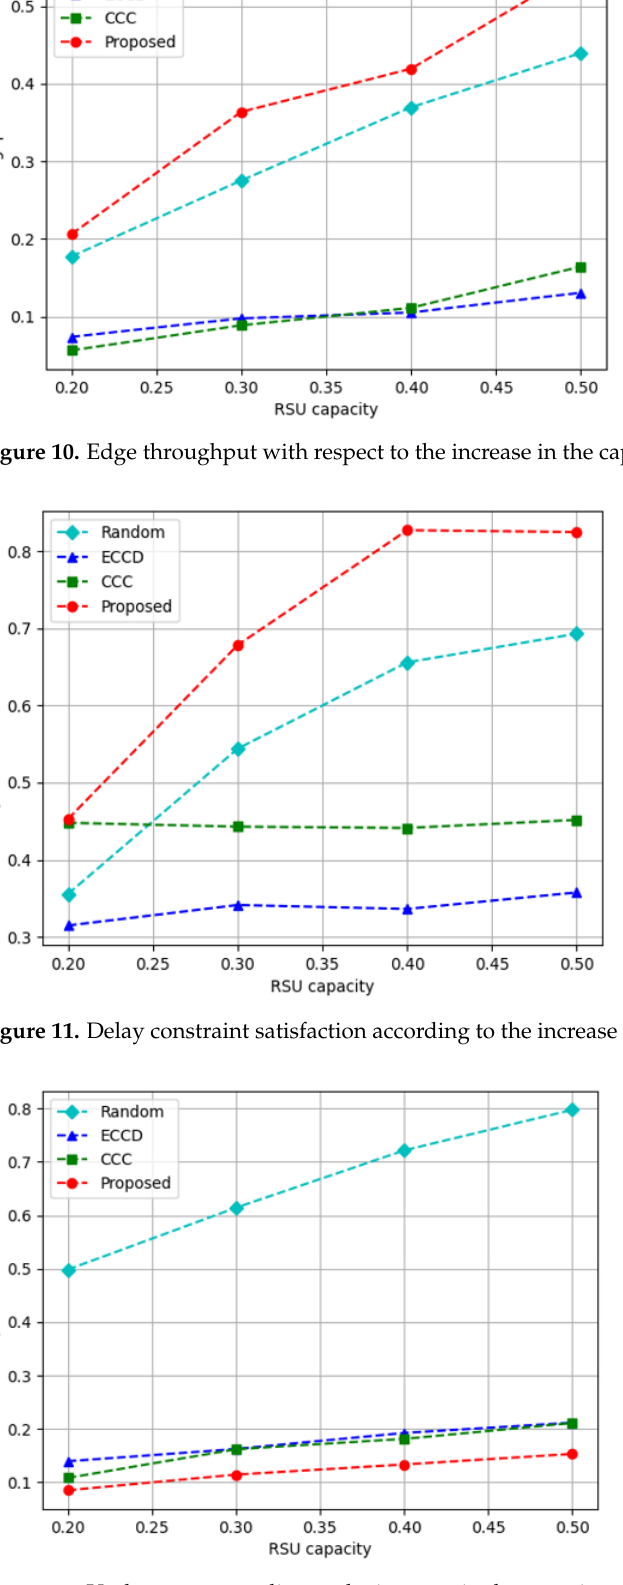
Figure 12. Update cost according to the increase in the capacity of RSUs.